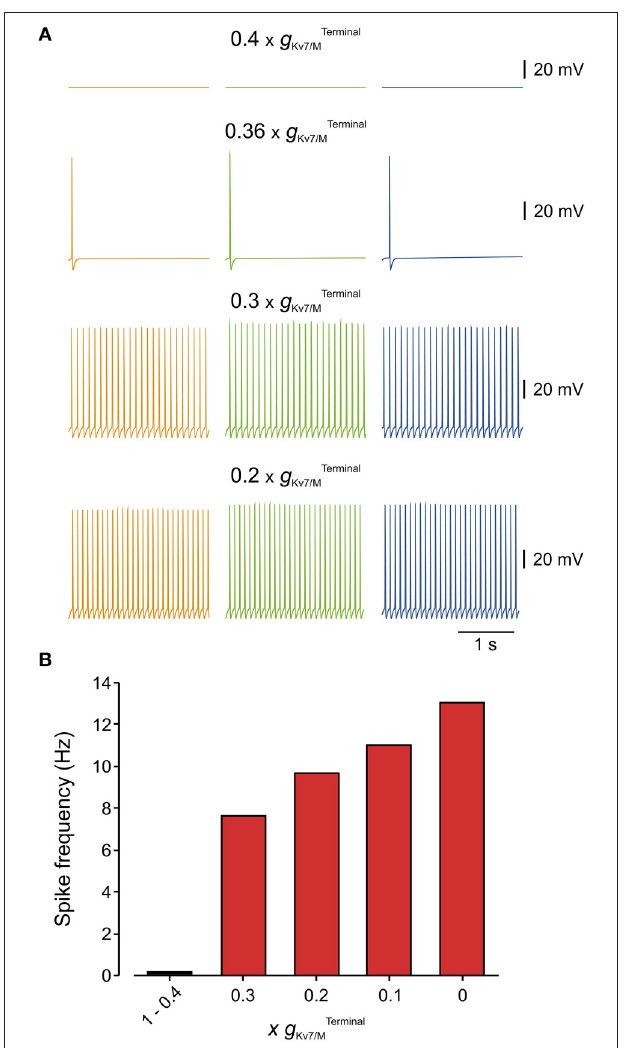
FIGURE 5 | Only 40% of terminal g Kv7 / M is sufficient to prevent spontaneous firing of the modeled multi-compartment nociceptive neurons. (A) Simulated recordings of changes in membrane potentials obtained from a multi-compartment model at peripheral axon ( orange ), soma ( green ), and central axon ( blue , see Figure 4 ). Monitoring of spontaneous firing was performed when different levels of g Terminal Kv7 / M were added to the model. Note that when 60% of g Terminal Kv7 / M was blocked (0.4 × g Terminal Kv7 / M ) the neuron was still silent. Inhibition of 64% of g Terminal Kv7 / M (0.36 × g Terminal Kv7 / M ) lead to spontaneous firing of 2 action potentials. Note also that the frequency of spontaneous firing increased with the decrease in g Terminal Kv7 / M. (B) Bar graph plotting the spike count at different levels of g Terminal Kv7 / M inhibition (shown as a factor by which g Terminal Kv7 / M was multiplied) measured from the central axon of the multi-compartment model ( blue electrode in Figure 4 ). At 1 × g Terminal Kv7 / M (no inhibition) till 0.4 × g Terminal Kv7 / M (60% inhibition) no spontaneous firing was observed, thus these values were combined into one bar.